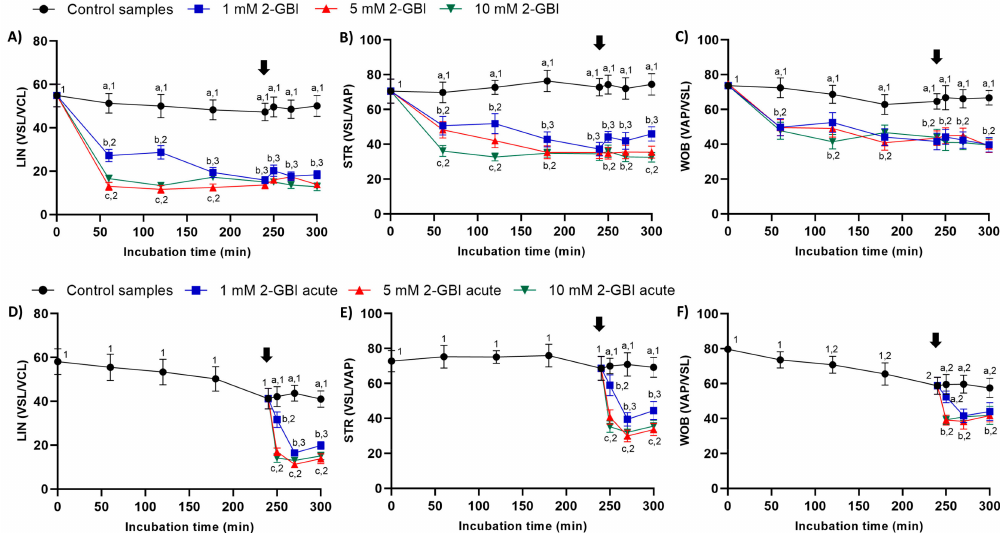
Figure 4. Indexes of linearity (LIN), straightness (STR) and oscillation (WOB) throughout the incubation of sperm in capacitating medium (control samples) and capacitating medium plus 1 mM, 5 mM or 10 mM 2-GBI, added at either 0 min in experiment 1 ( A – C ) or 240 min in experiment 2 ( D – F ; acute). Di ff erent superscript letters (a–c) indicate significant di ff erences ( p < 0.05) between treatments within the same time point, and di ff erent superscript numbers (1–3) indicate significant di ff erences ( p < 0.05) between time points within a given treatment. Results are expressed as mean ± SEM ( n = 10). The arrow indicates the time at which 10 µ g / mL of progesterone was added to all samples (i.e., 240 min of